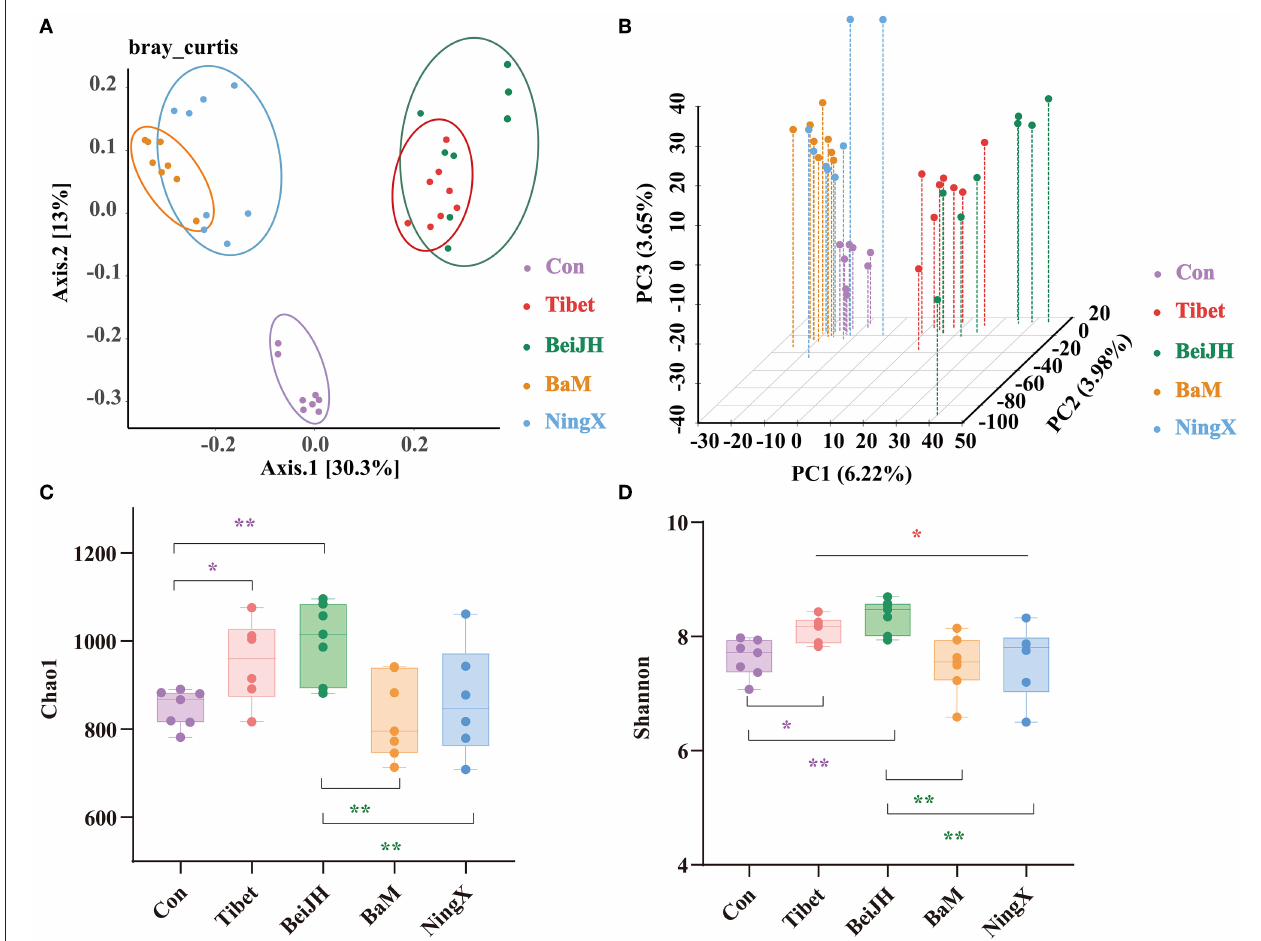
FIGURE 2 | Species diversity analysis of microbial community. (A) Scatterplot from principal coordinates analysis (PCoA) in bacterial communities of fecal microbiota on genus level based on the bray_curtis distance. (B) 3D scatterplot from PCA in bacterial communities of fecal microbiota on genus level. The bacterial α diversity of fecal microbiota of piglets based on (C) Chao1 and (D) Shannon indexes. Data were shown as mean ± SD (n ≤ 8). Student’s T -test was conducted. * P < 0.05; ** P <